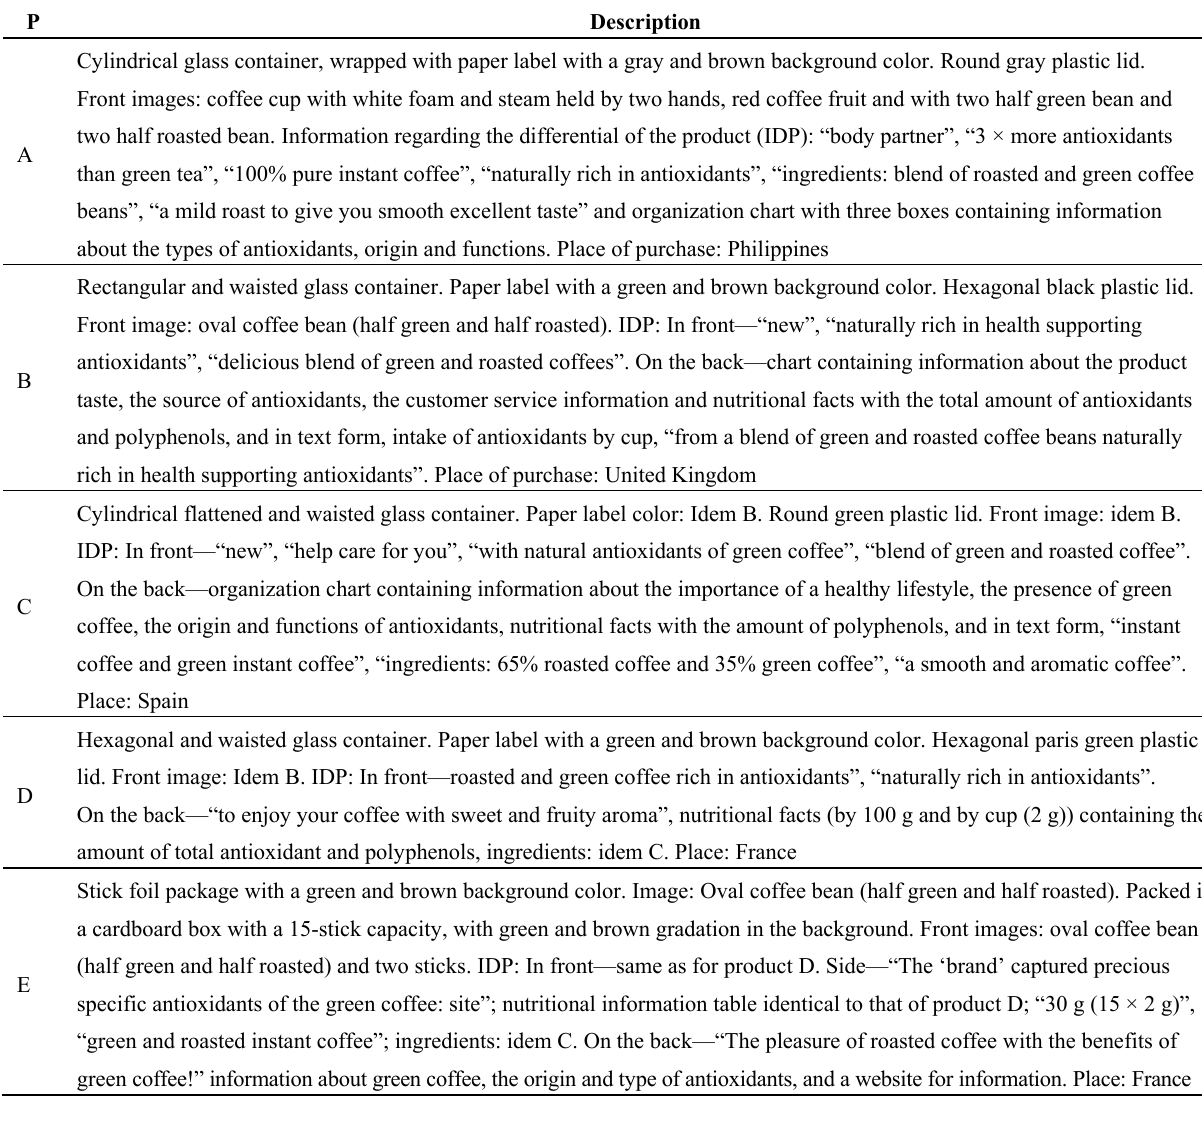
Table 1. Description of the packages (P) of commercial antioxidant-rich instant coffees, of same brand, used in the focus group